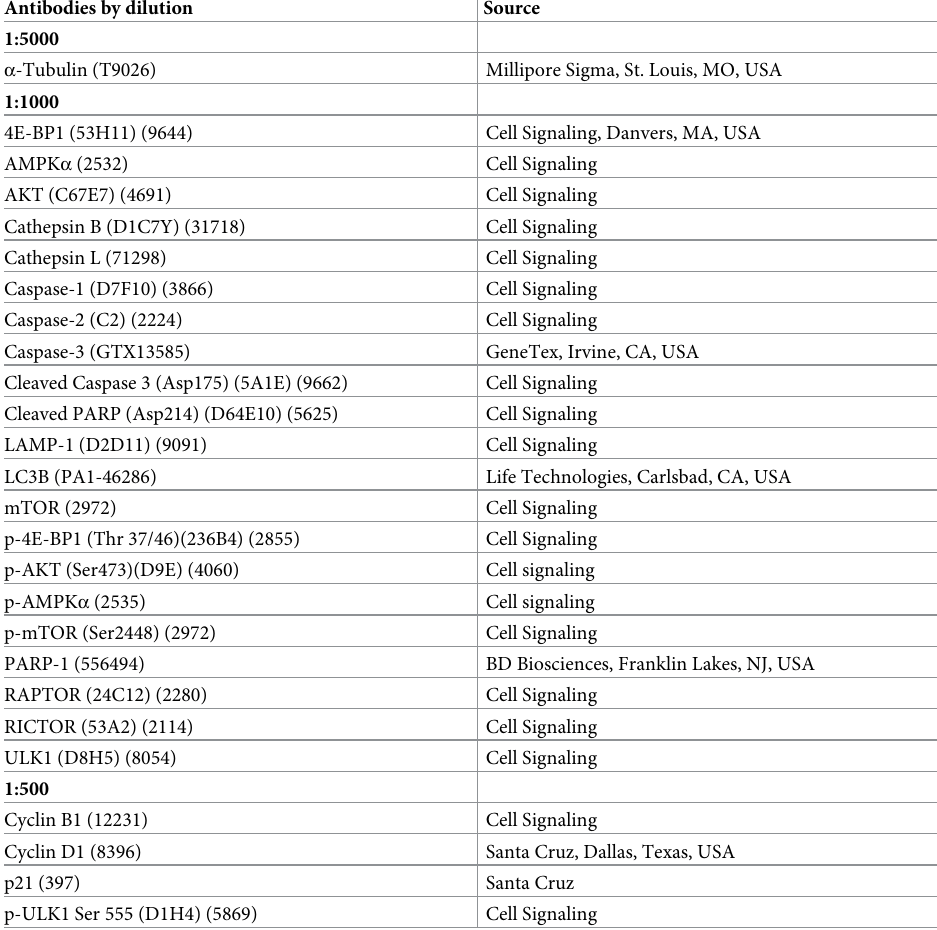
Table 1. Antibodies used for immunoblotting